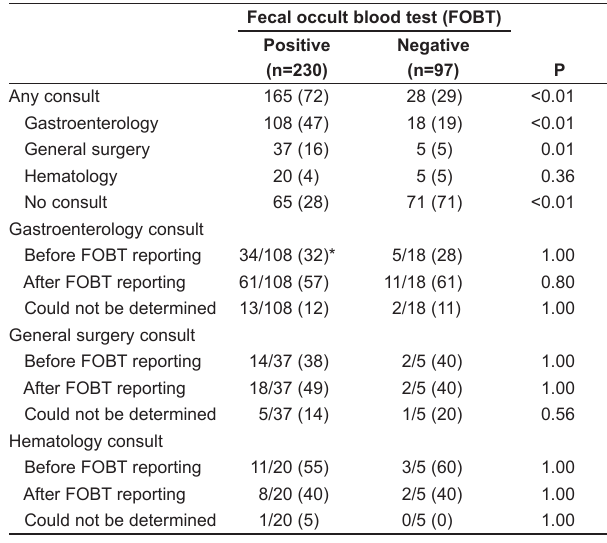
TAble 3 indications* for ordering a fecal occult blood test (FObT)